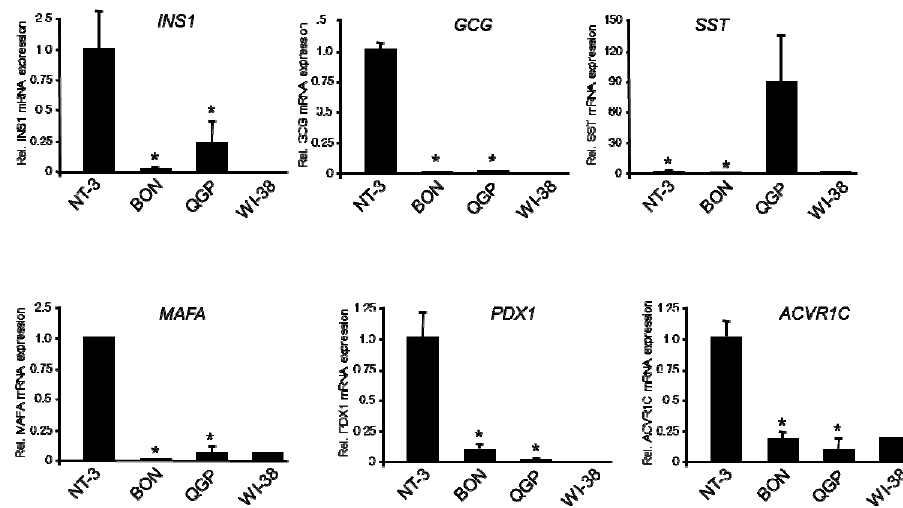
Figure 3. Quantitative real-time RT-PCR-based expression analysis of the indicated genes for islet hormones (INS1, GCG, SST) and marker genes of mature β -cell differentiation or function (MAFA, PDX1, ACVR1C) in BON, QGP, and NT-3 cells. Data represent the mean ± SD from three to four preparations. The asterisks ( ∗ ) indicate significant differences relative to NT-3 cells ( p < 0.05, Wilcoxon test).